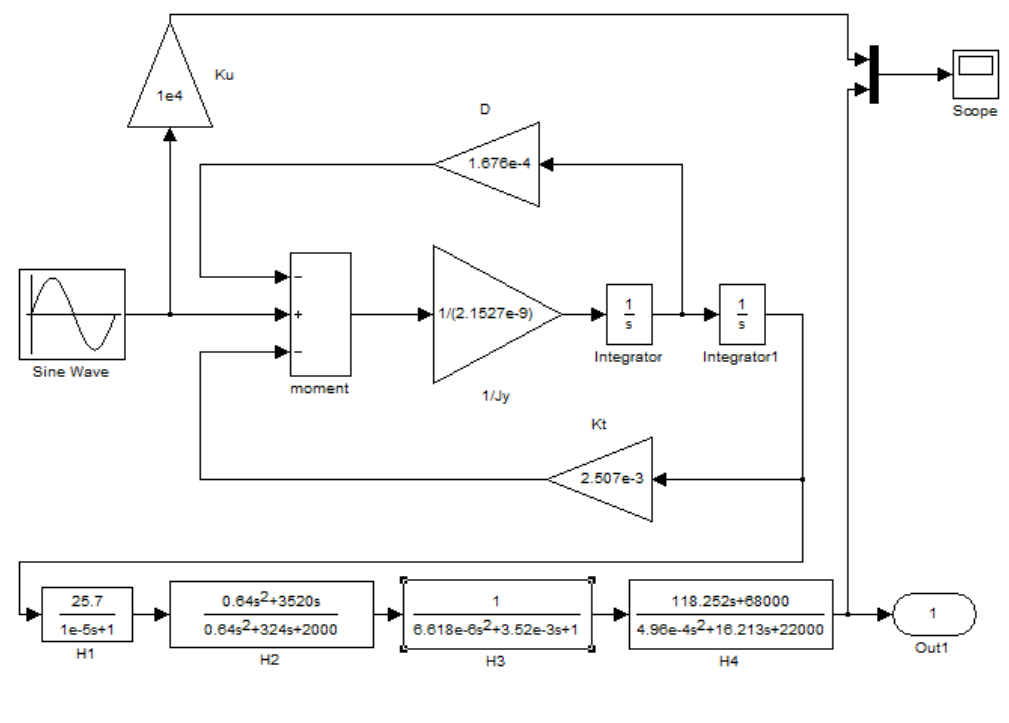
Figure 16. Modeling of the dynamic